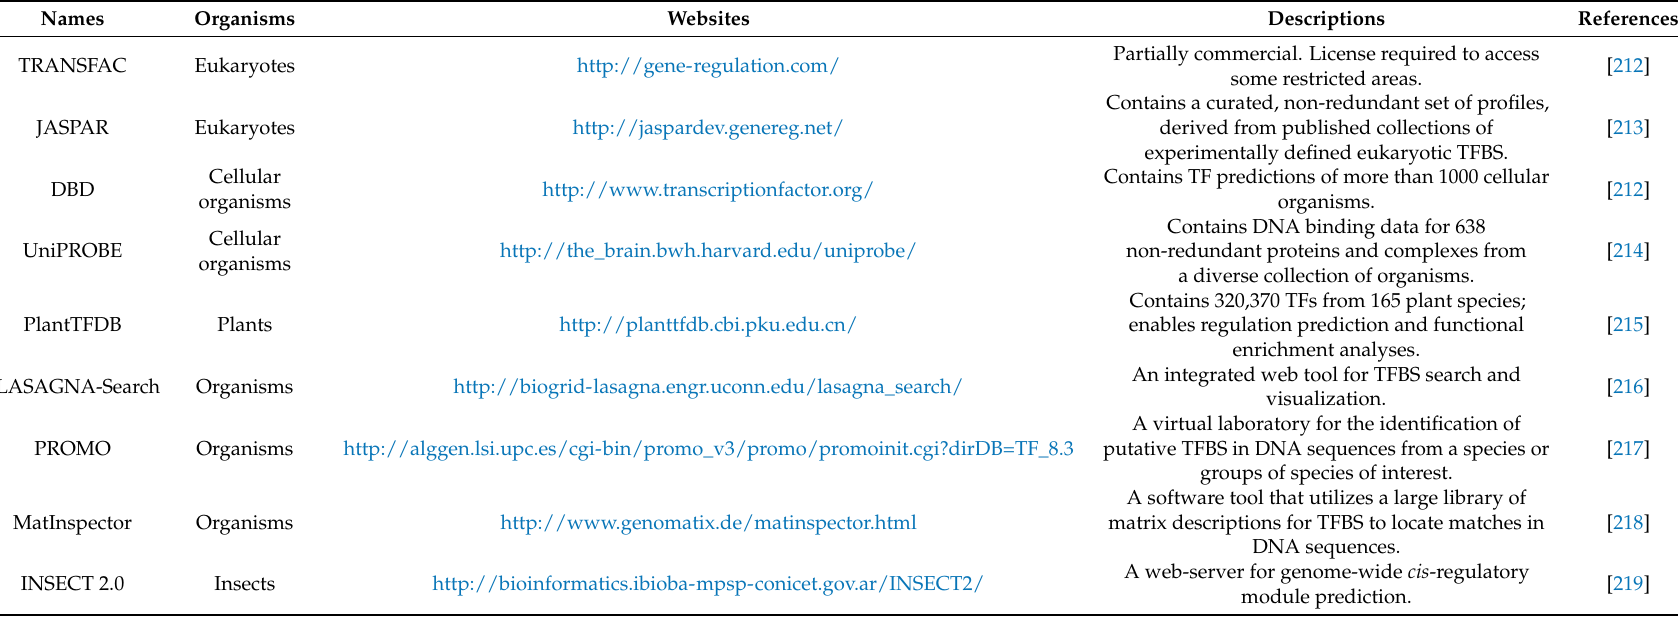
Table 1. In silico TF-binding site (TFBS) prediction by utilizing different TF databases and TFBS searching